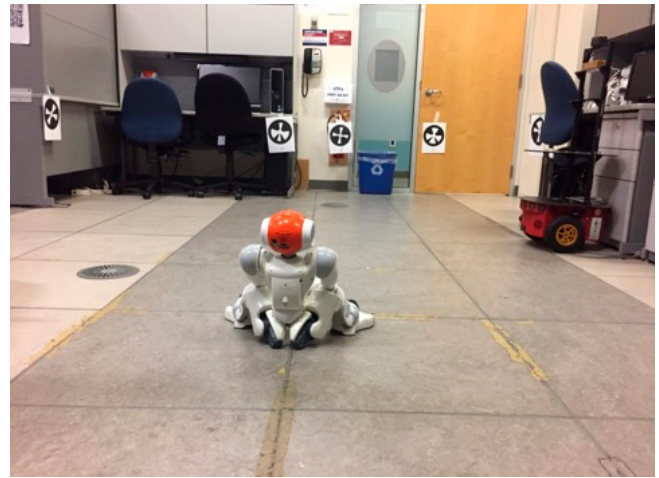
Figure 15. Experimental environment.